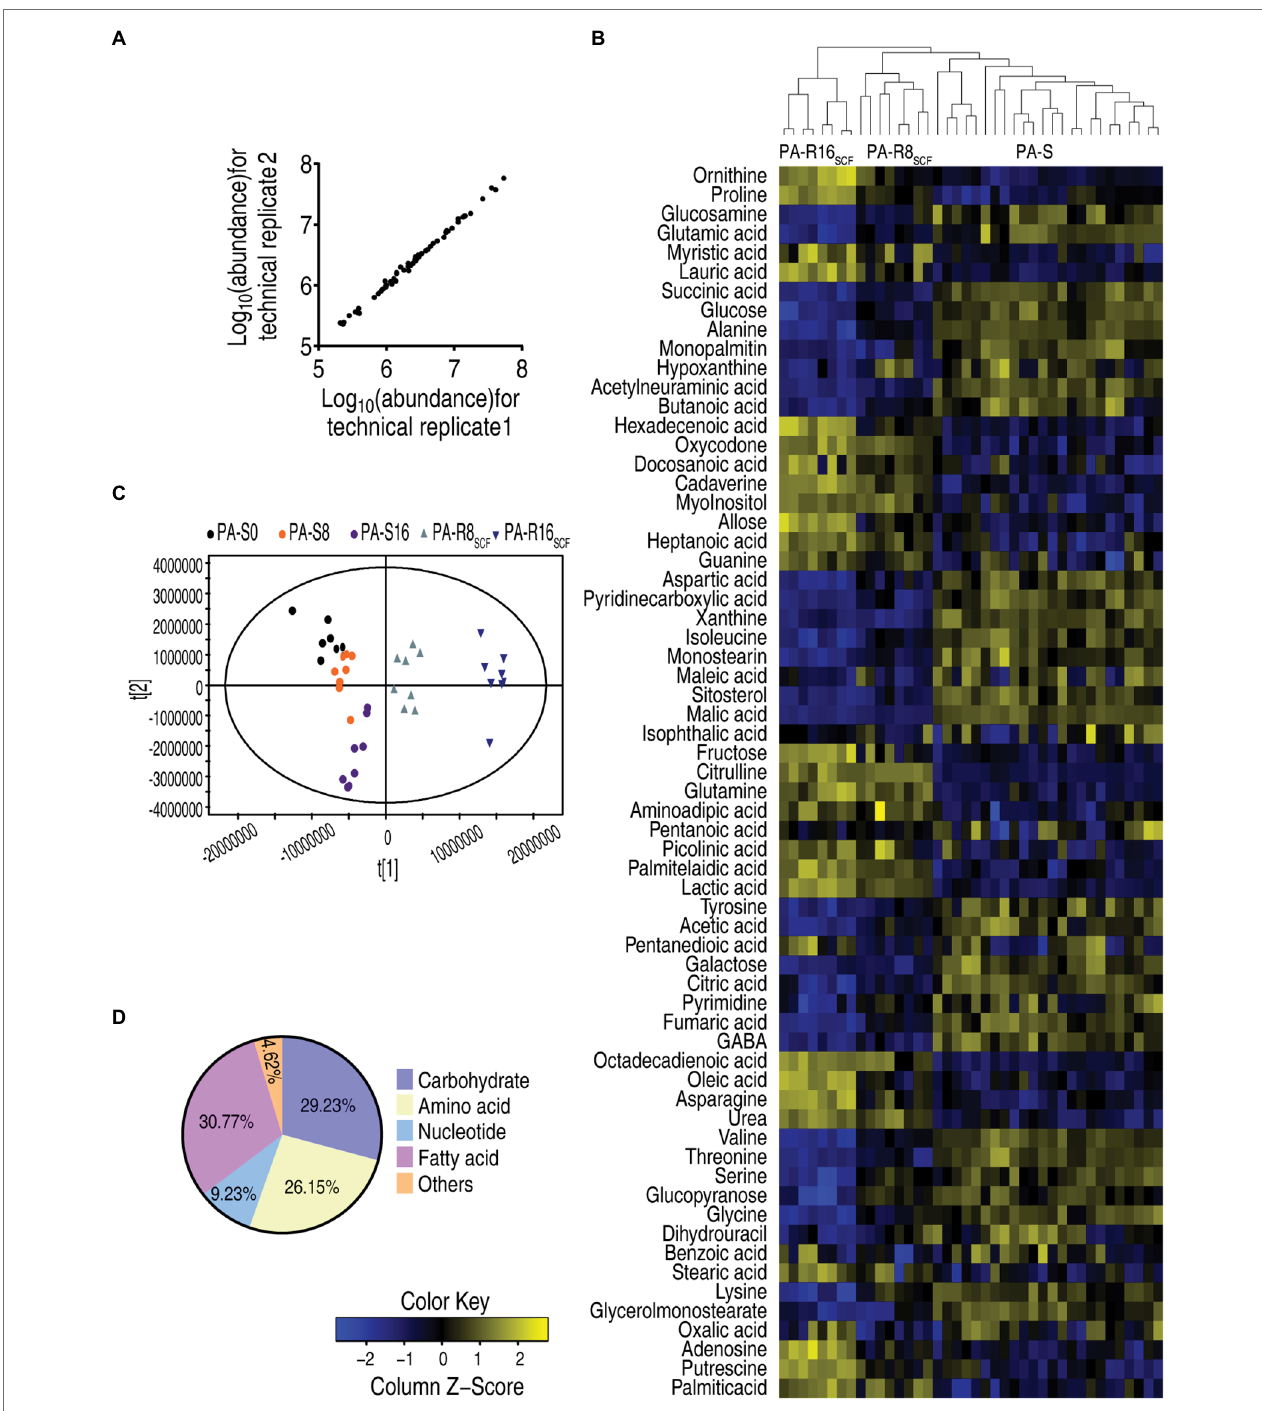
FIGURE 2 | Metabolic profiles between three PA-S and two PA-R strains. (A) Reproducibility of the metabolomic profiling platform used in the discovery phase. Abundance of metabolites quantified in samples over two technical replicates is shown. The Pearson correlation coefficient between technical replicates varies between 0.998 and 0.999. (B) Heat map of unsupervised hierarchical clustering of different metabolites (row). Blue and yellow indicate decrease and increase of the metabolites scaled to mean and SD of row metabolite level, respectively (see color scale). (C) Principal component analysis (PCA) of the three PA-S and two PA-R strains. Each dot represents the technical replicate of samples in the plot. (D) Categories of the metabolites. Sixty-four metabolites are searched against in KEGG for their categories, and the pie chart is generated in Excel 2010 (Microsoft, United